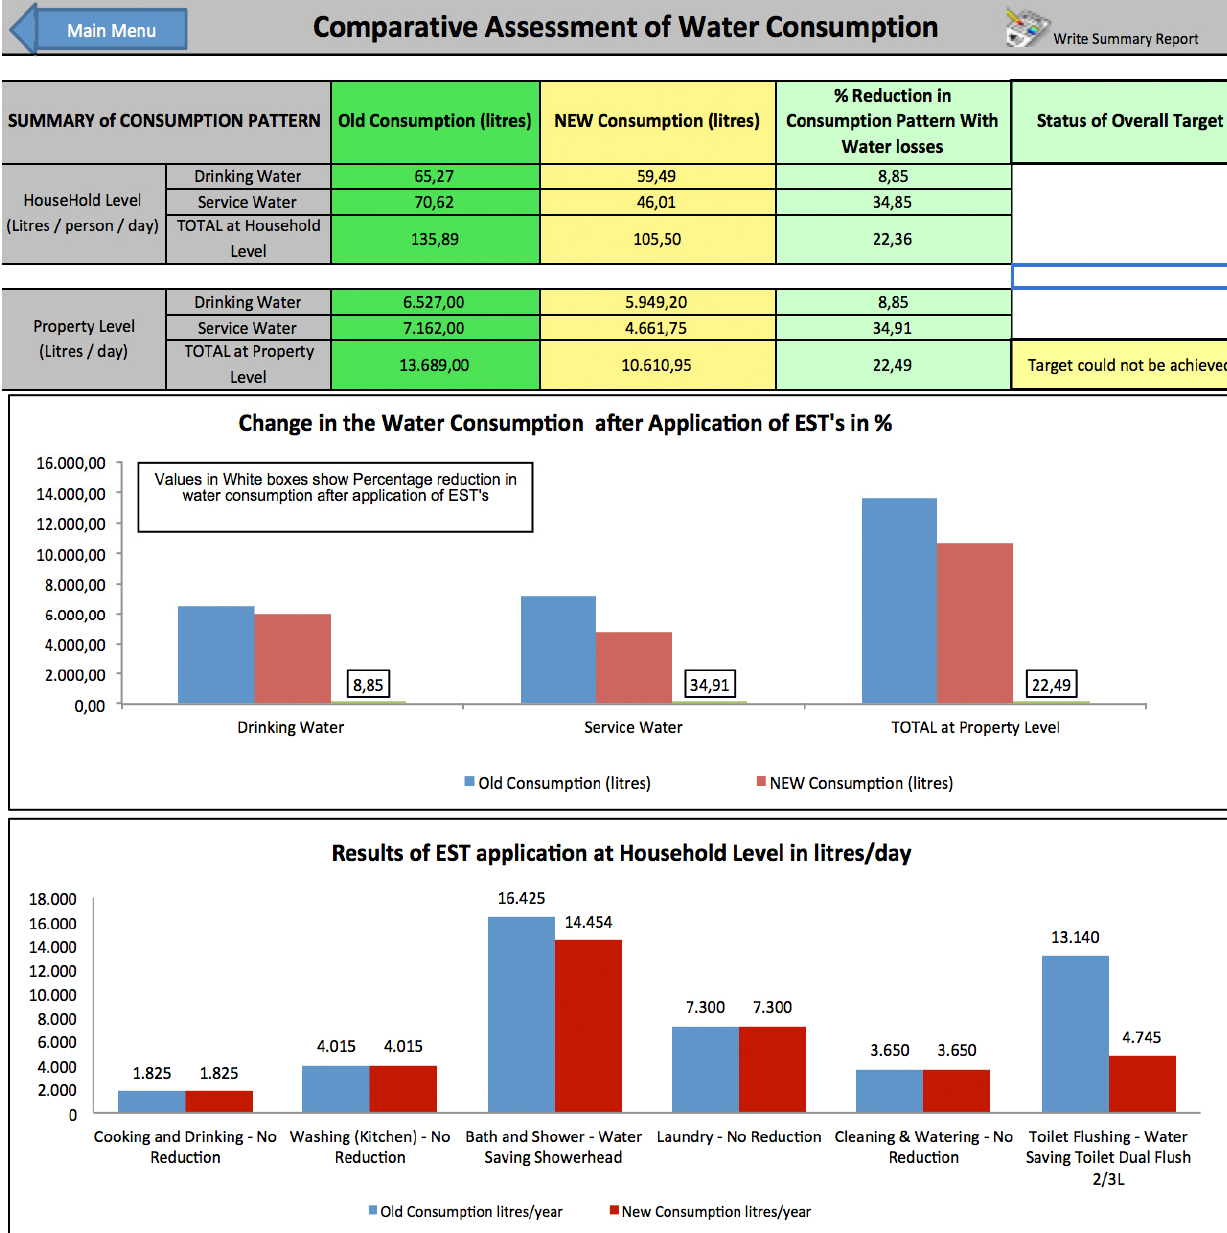
Figure 9. “Summary” sheet in “Wise Water” with summary of water consumption pattern and graphics displaying change in the water consumption after application of ESTs, and results of EST